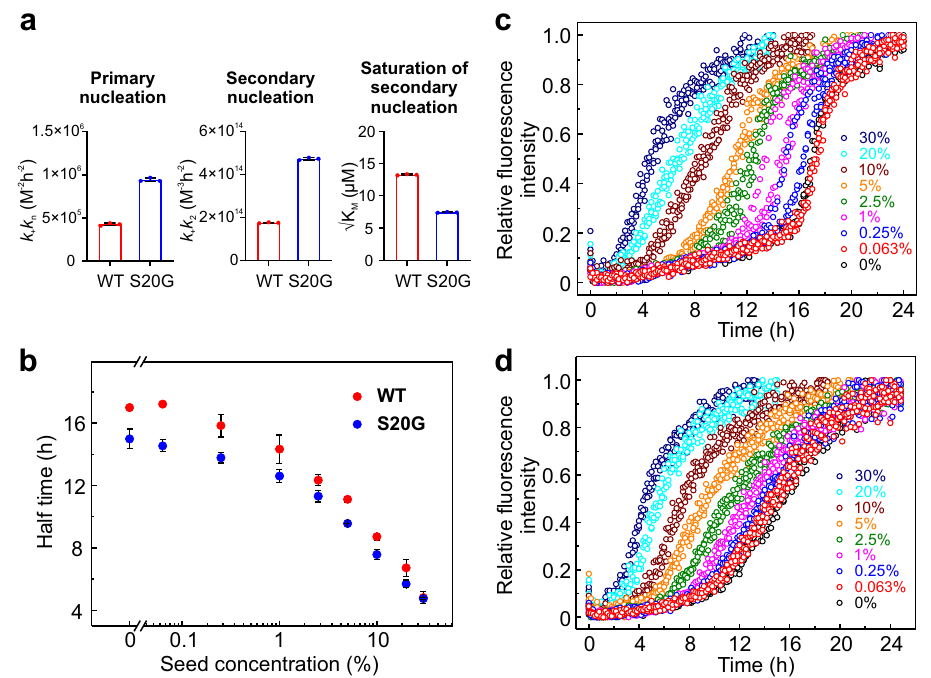
Fig. 3 Parameters obtained by global fi tting of wt hIAPP and S20G aggregation kinetics and seeding reactions. a The combined rate constants ( k + k n and k + k 2 ) and monomer concentration of half-saturation of secondary nucleation ( √ K M ) obtained from global fi tting of the experimental kinetic data shown in Fig. 2 for wt hIAPP (red) and S20G (blue). Bars represent the mean and error bars show standard deviation ( n = 3), with values for each replicate shown as points. b Half time (t 50 ) as a function of the logarithm of the seed concentration for wt hIAPP (red) and S20G (blue). Results are mean ± SD of n = 3. Aggregation kinetics of c wt hIAPP and d S20G in the presence of preformed self-seeds. 10 μ M monomer wt hIAPP/S20G was incubated with 0%, 0.063%, 0.25%, 1%, 2.5%, 5%, 10%, 20% or 30% (v/v) preformed self-seeds in 25 mM sodium phosphate buffer, pH 6.8 at 30 °C quiescently. Each experiment was performed twice with three technical replicates each time using different batches of the